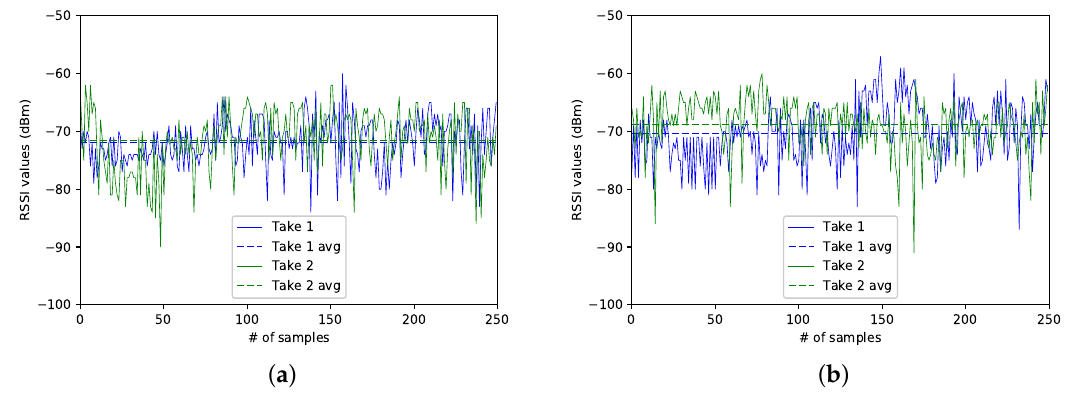
Figure 5. Sector 8: Comparison of the RSSI from different BLE4.0 beacons for Tx = 0x04. ( a ) for Be07; ( b ) for Be10.